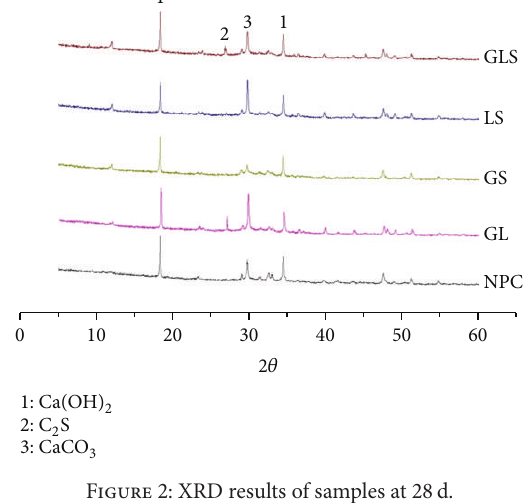
Figure 2: XRD results of samples at 28 d.